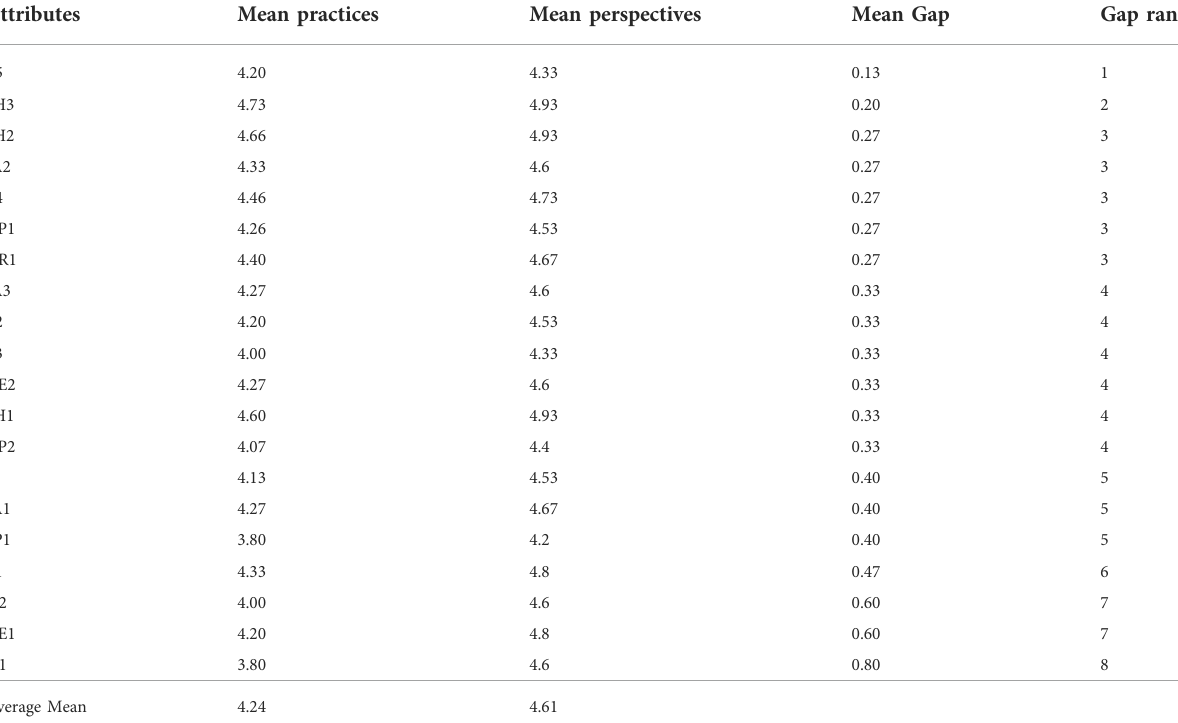
TABLE 6 Mean and gap analysis of perspectives and